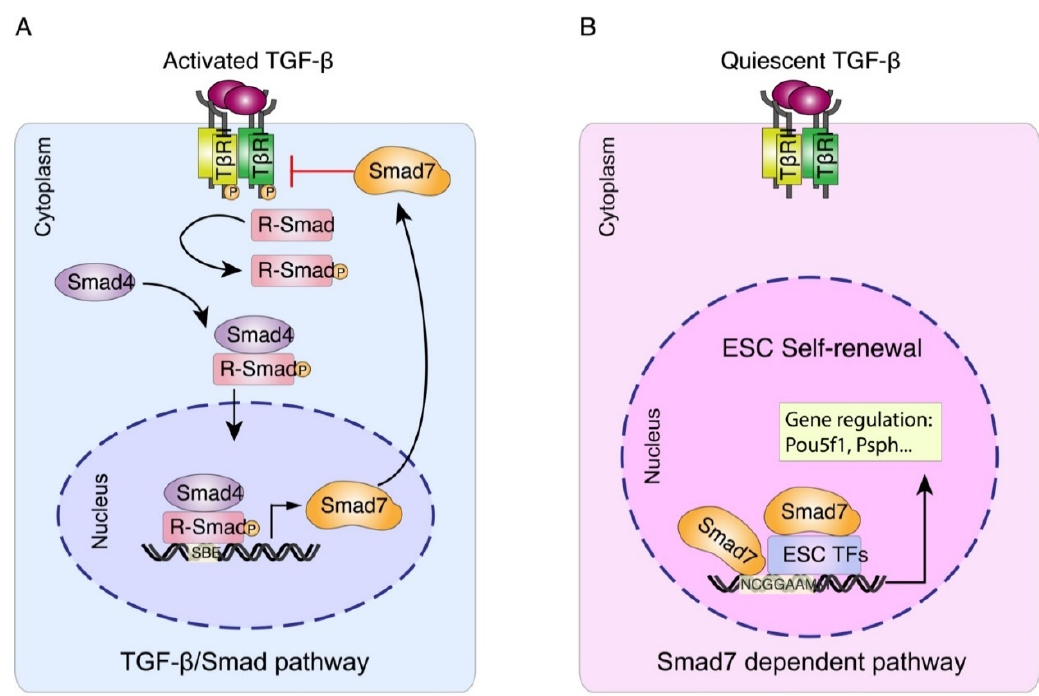
Figure 5. Working model for Smad7-mediated transcriptional regulation in mESC. ( A ) Upon TGF β /Smad pathway activation, Smad7 can function as a TGF β antagonist in the cytoplasm [11,12]. ( B ) Our study illustrates Smad7 functions as a transcription factor and regulates the target gene expression independently or by interacting with other ESC factors in the nucleus, thus promoting ESC self ‐ renewal and pluripotency maintenance.